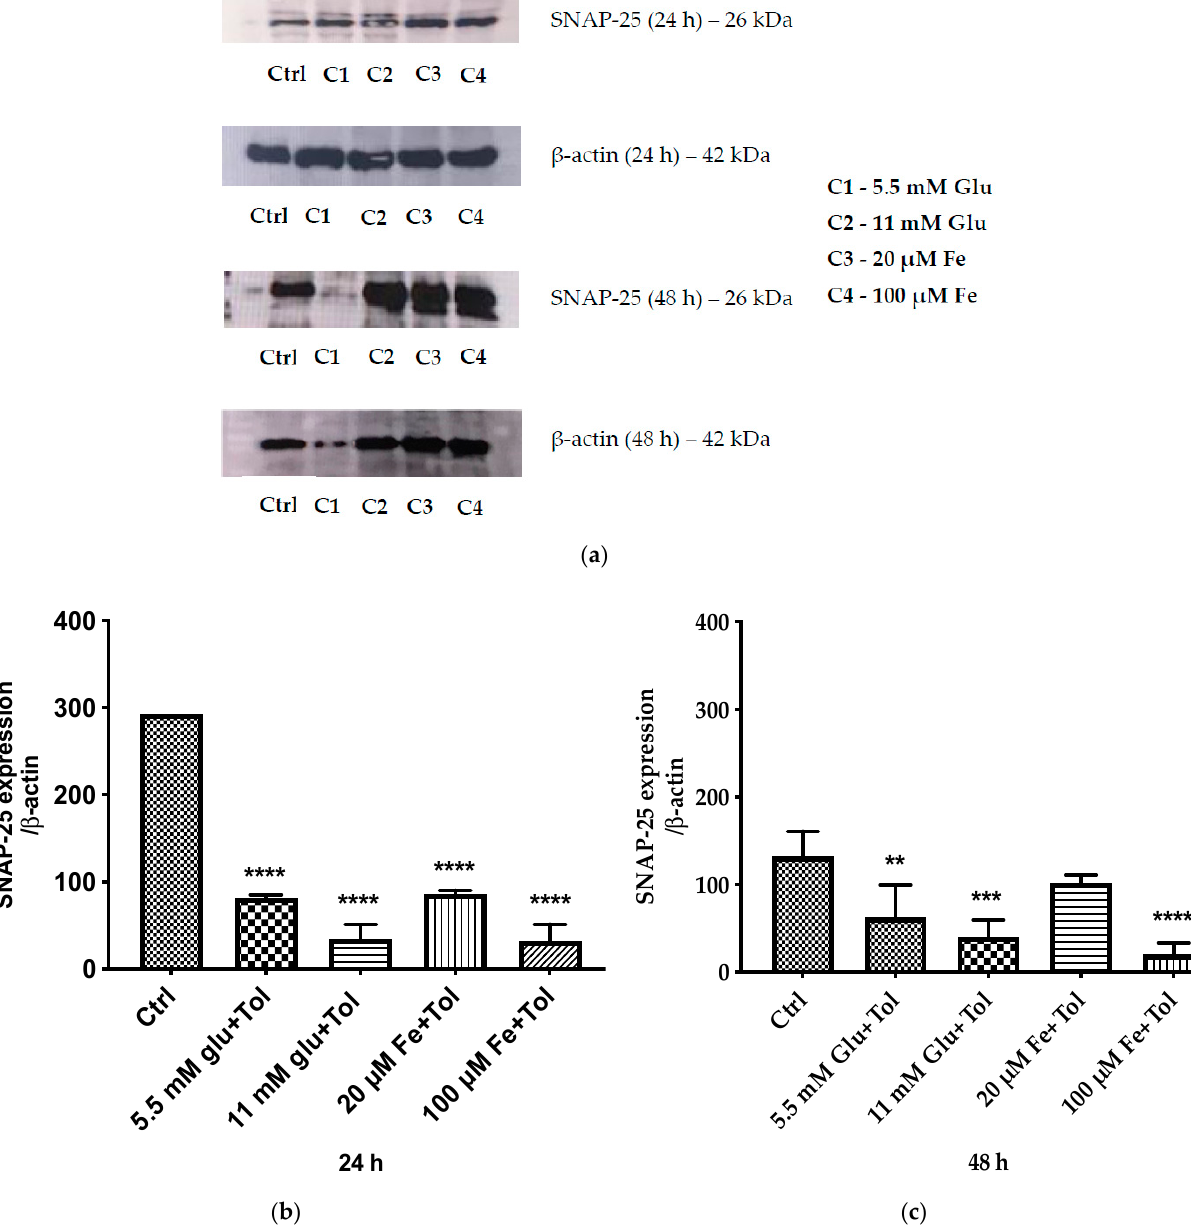
Figure 8. SNAP-25 protein expressions in pancreatic β -cell (MIN6) within two distinct timelines, 24 and 48 h, in the presence of iron (20 µM and 100 µM) and glucose (5.5 mM and 11 mM) with the addition of tolbutamide as a secretagogue. Protein expression was identified using Western blotting. ( a ) Distinctive bands of SNAP-25 (24 and 48 h) and β -actin (24 and 48 h). Gel loading was as follows (from top left): lane 1—ctrl, lane 2—normal glucose (5.5 mM) (C1), lane 3—high glucose (11 mM) (C2), lane 4—normal iron (20 µM) (C3), lane 5—high iron (100 µM) (C4); (from middle right): lane 1—ctrl, lane 2—C1, lane 3—C2, lane 4—C3, lane 5—C4. ( b ) Expression of SNAP-25 at 24 h normalised against β -actin. ( c ) Expression of SNAP-25 at 48 h normalised against β -actin. The data represent mean ± SEM; n = 4. **** p < 0.0001 (24 h), ** p < 0.0061 (48 h), *** p < 0.0005, **** p < 0.0001 (48 h).